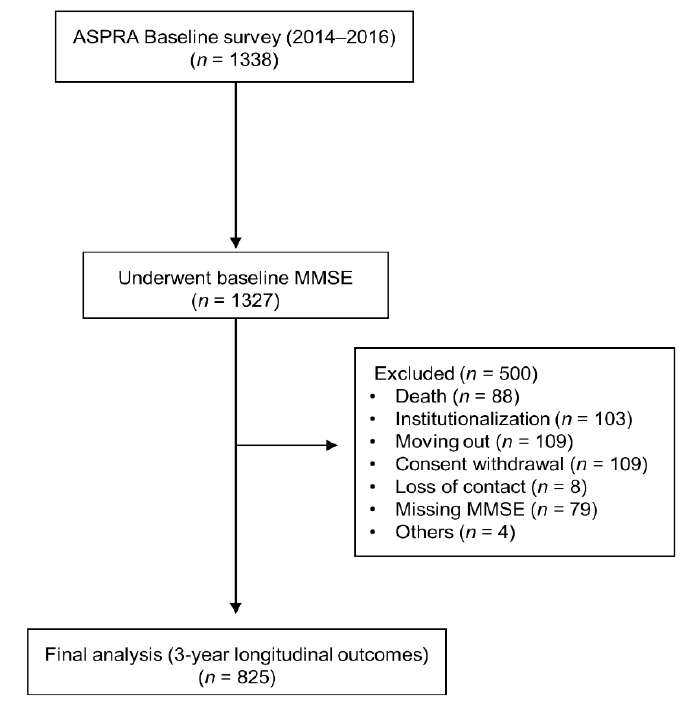
Figure 1. Flow chart of the study population.